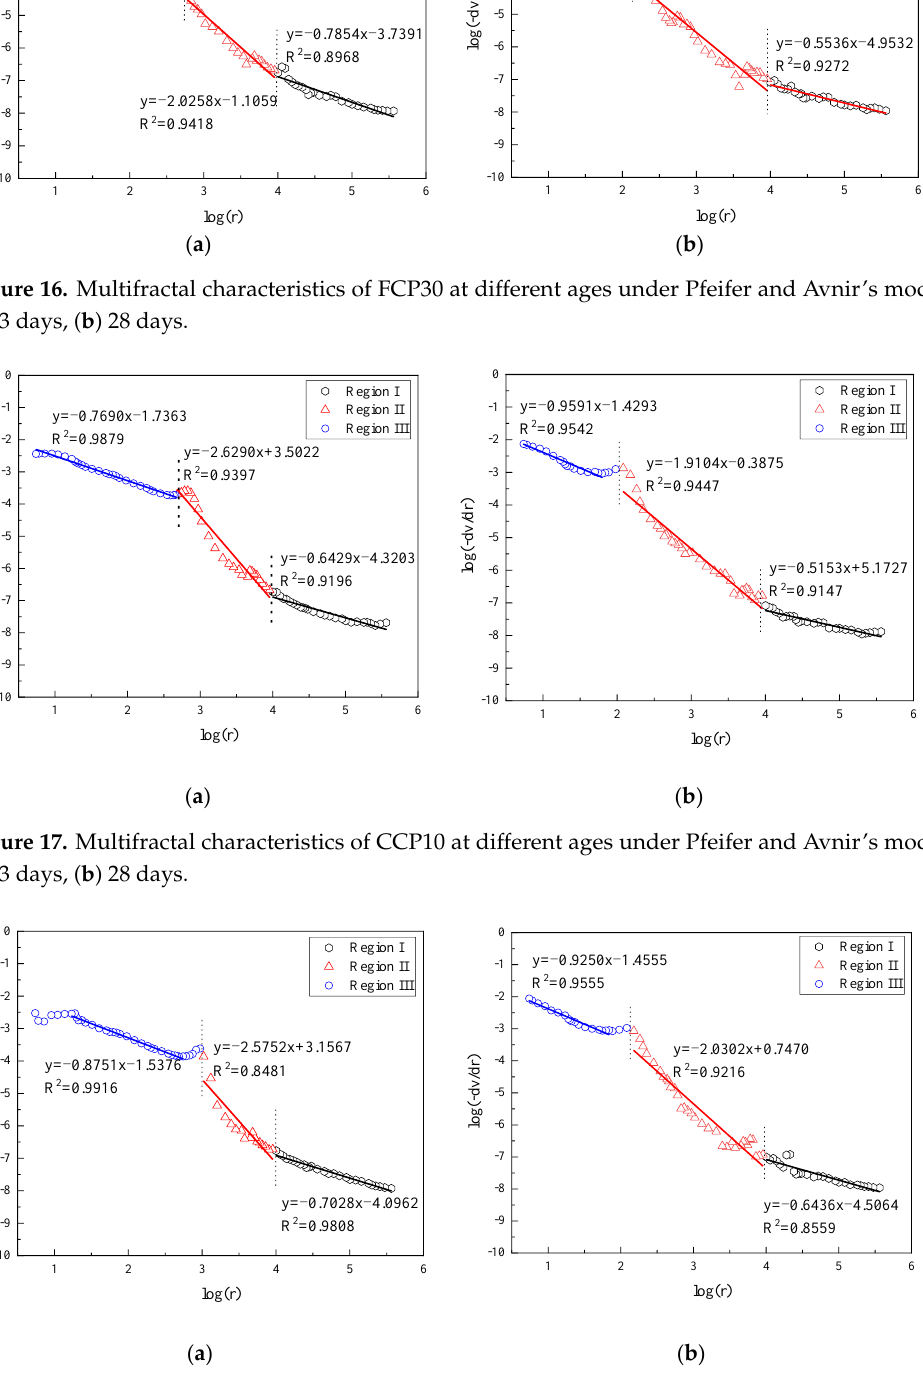
Figure 18. Multifractal characteristics of CCP30 at different ages under Pfeifer and Avnir’s model. ( a ) 3 days, ( b ) 28 days.